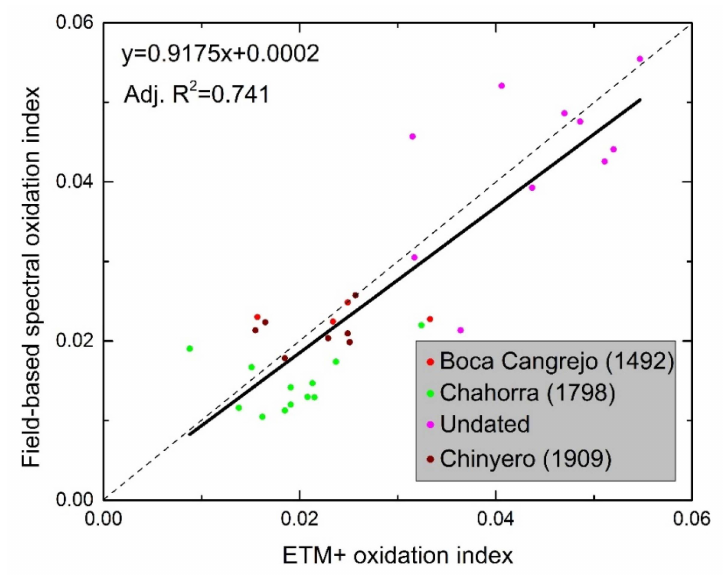
Figure 10. Correlation between the subtraction oxidation index (ref 630 ´ 690 ´ ref 450 ´ 520 ) derived from the Landsat ETM+ image bands 1 and 3 and from the field spectral data, for 33 lava sites measured on the Boca Cangrejo, Chahorra, Chinyero and prehistorical lava flows. The grey dashed line is the 1:1